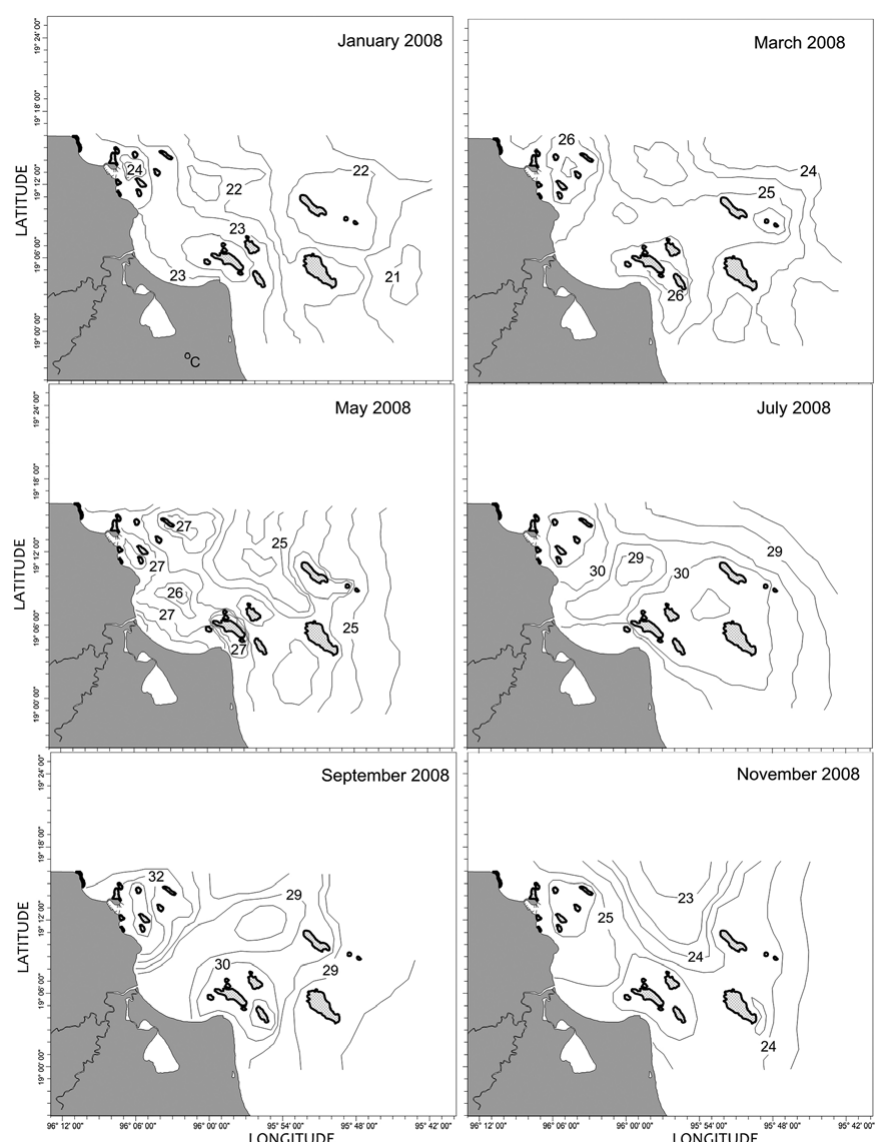
Fig. 5. – The residual sea surface temperature (0.5 m depth) in degrees Celsius (°C) recorded on 18 January, 21 March, 16 May, 18 July, 19 September and 21 November